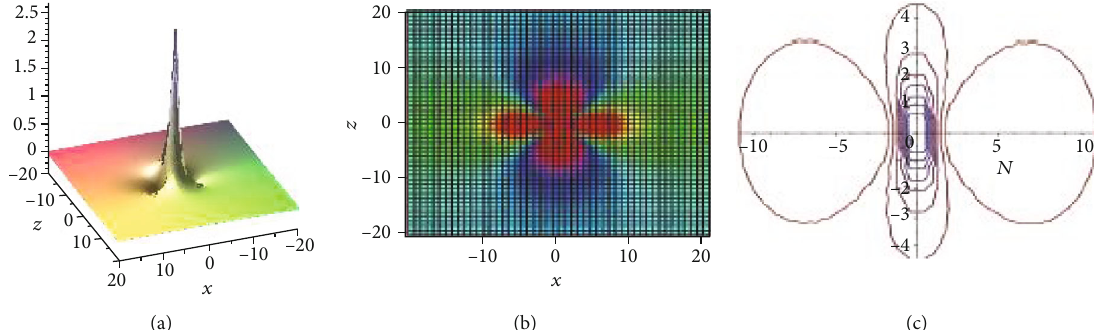
= 0, α = 0, β = 0 . (a) Perspective view of 0